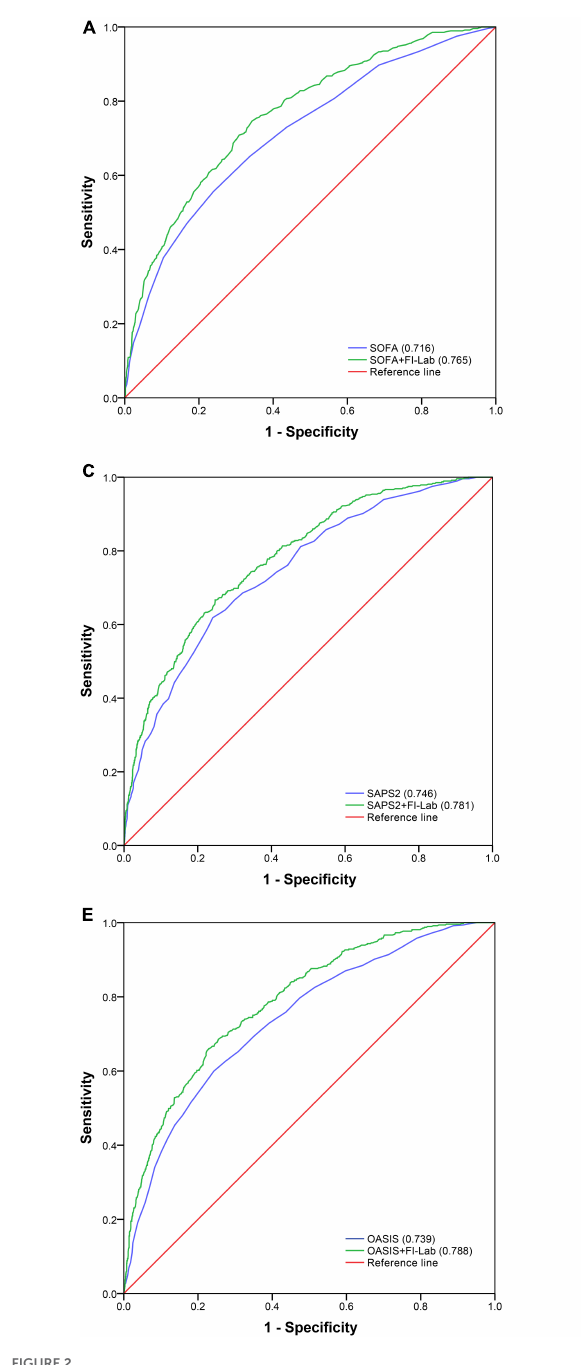
Acute physiology score (APS) 3 and SAPS 2 had good discrimination abilities for 1-year mortality (AUROC = 0.723 and 0.720, respectively); SOFA, LODS, and OASIS had moderate discrimination abilities (AUROC = 0.636, 0.696, and 0.668, respectively); and SIRS had poor discrimination ability